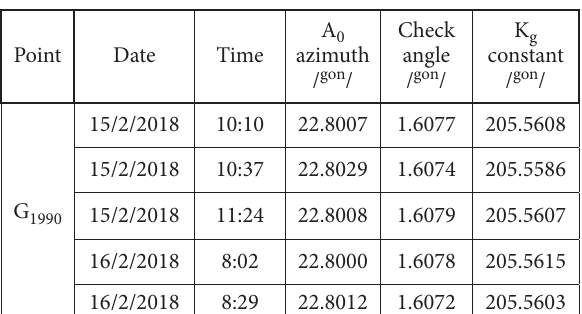
Table 7. Gyro station constants